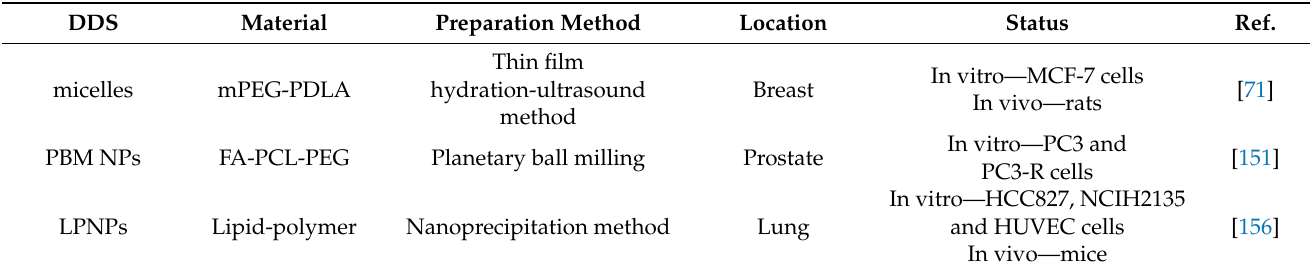
Table 4. Examples of Res and Dtx-loaded delivery systems for anticancer